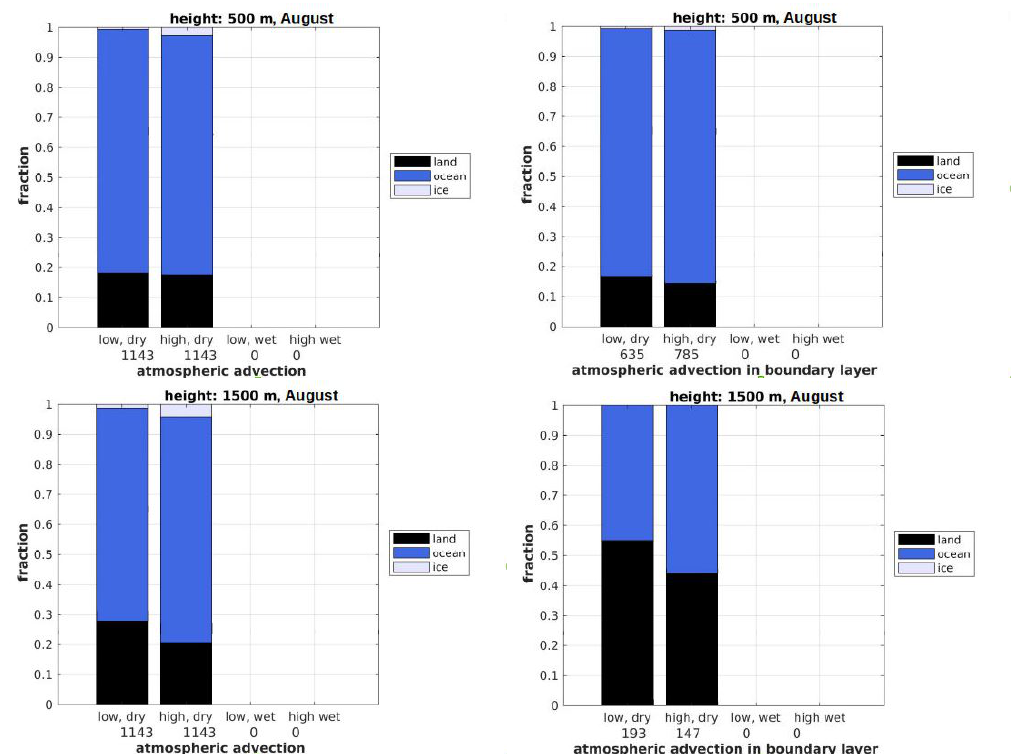
Figure 14. Fraction of how long the air parcel was over land, ocean, or ice. Left: All data points are plotted, independent of the height of the air parcel. Right: Only the cases are plotted where the air parcel was within the boundary layer (defined as p > 900 hPa). This plot only shows the data for the arriving heights of 500 m and 1500 m above Zeppelin Station for all Augusts, 2013–2017. The numbers below the bars indicate the total number of points for each